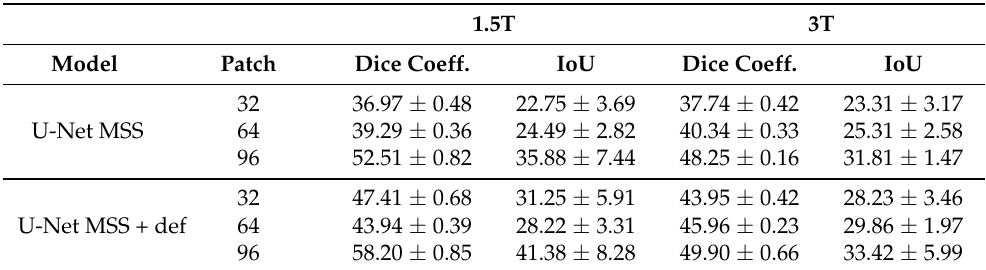
Figure 8. Qualitative evaluation of U-Net MSS with and without deformation-aware learning, while segmenting 1.5T and 3T MRA volumes from the IXI dataset. The inference was performed using two different patch sizes: 64 and 96. Red indicates false negative, and blue indicates false positive, while being compared against the dataset labels created with Ilastik. Table 4. Quantitative evaluation using Dice scores for 1.5T and 3T IXI dataset with different patch